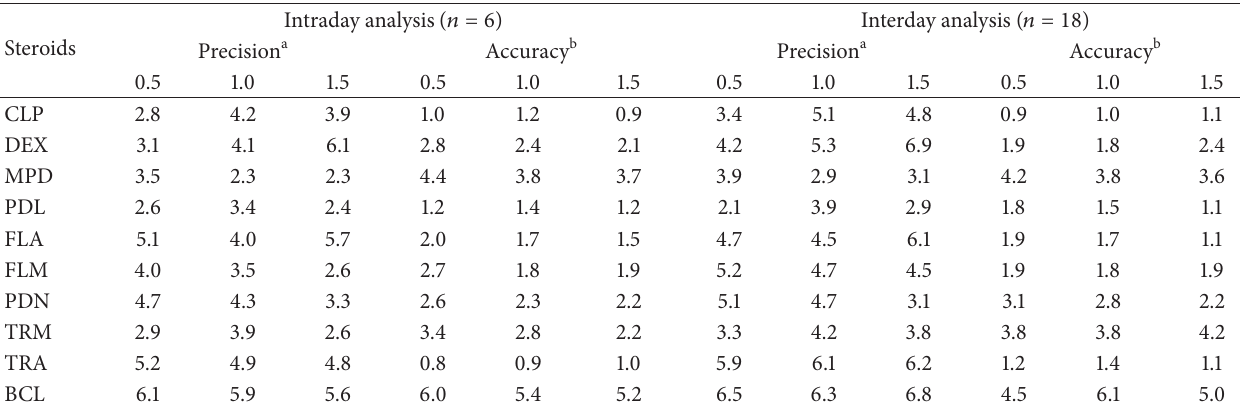
Table 4: Validation data of precision and accuracy for samples containing spiked standard solutions in blank cosmetic preparations. a RSD